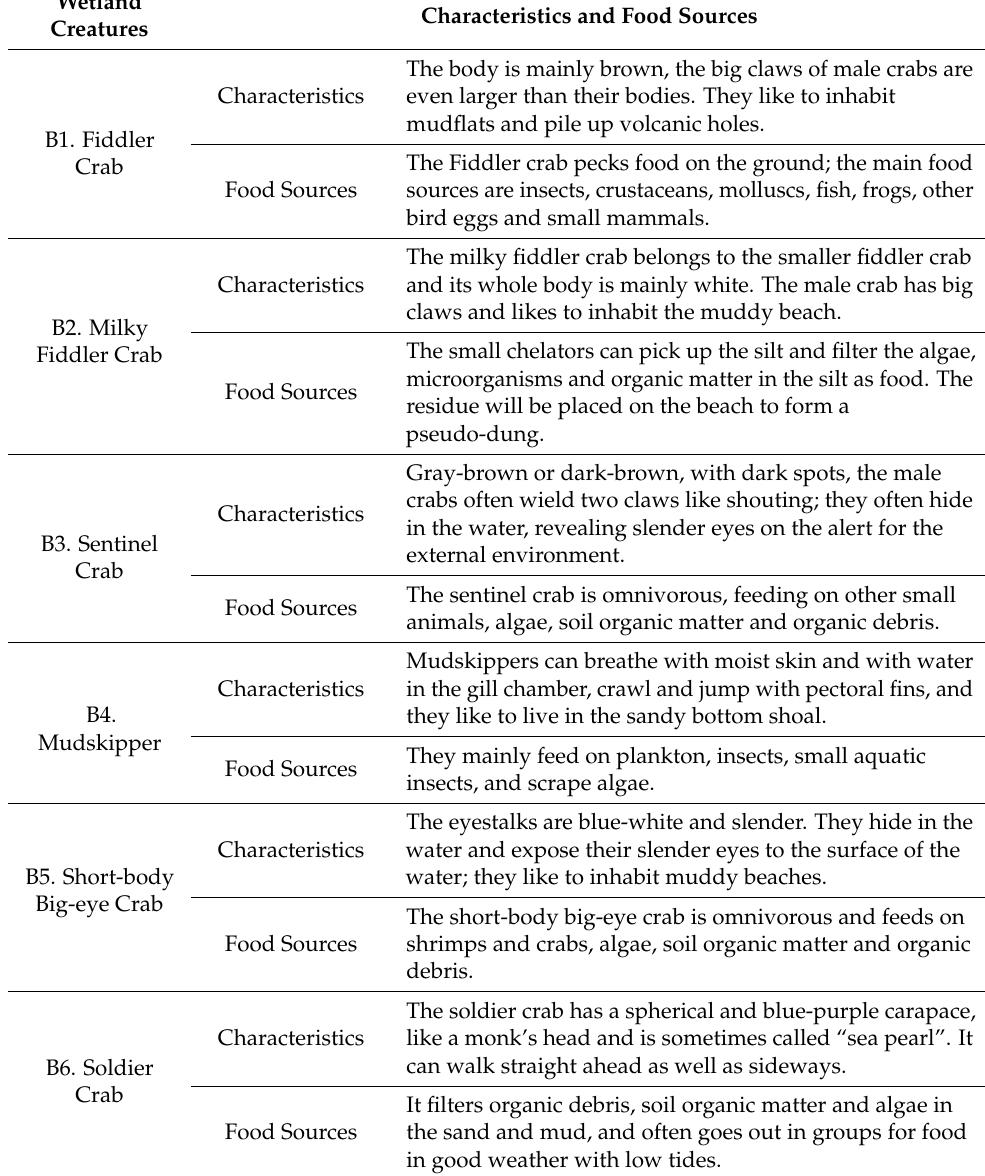
Table 3. Hsiang Shan wetland area and its creatures’ characteristics and food